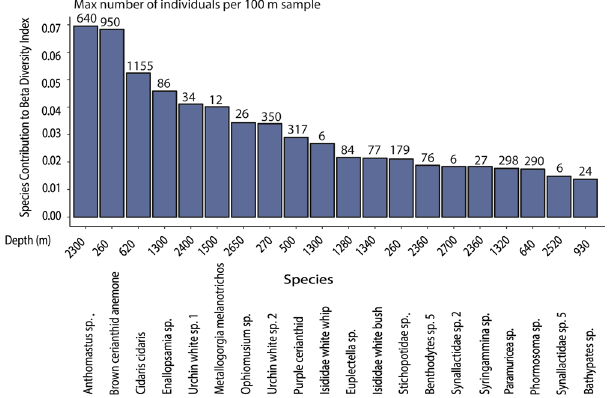
Figure 5. The contribution of the top 20 individual species to beta diversity and the maximum number of individuals per 100 m sample and corresponding depth.